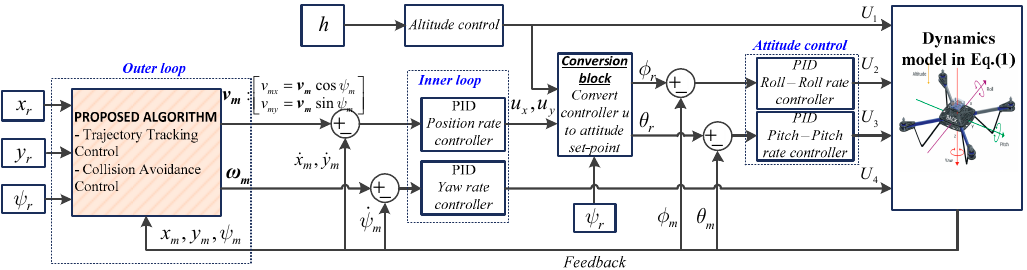
Figure 5. General block diagram of the proposed algorithm.